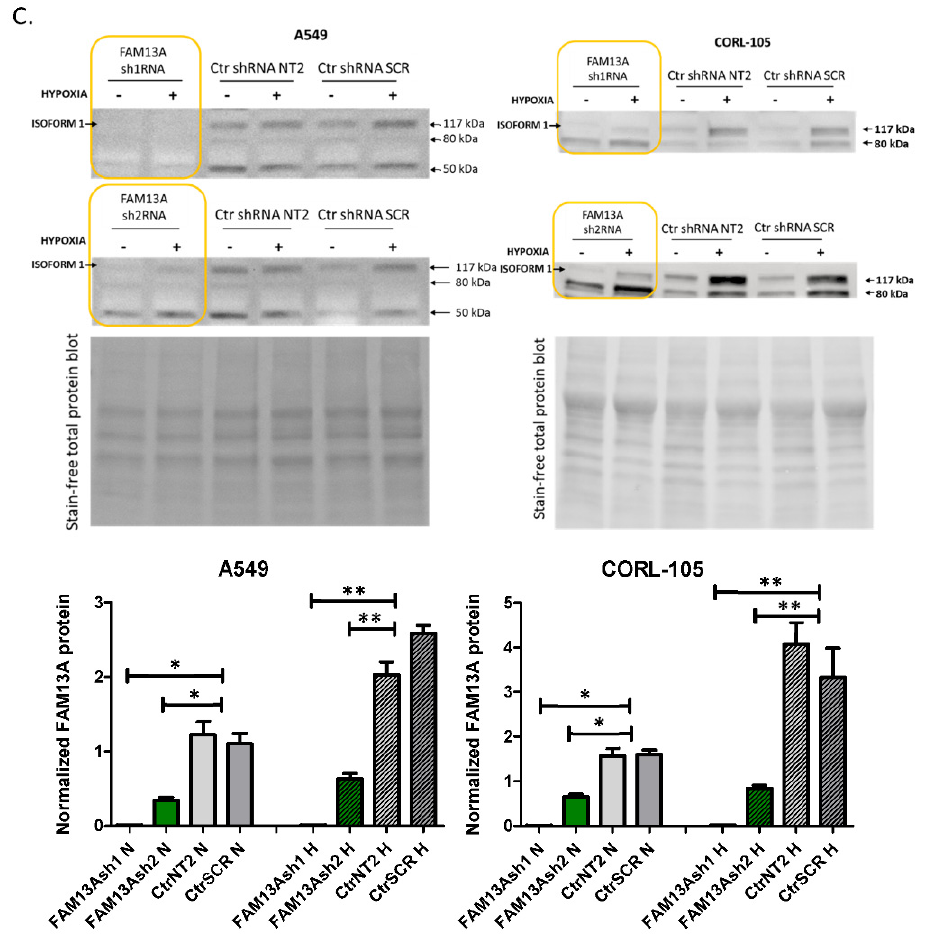
Figure 1. Generating lung cancer cell lines with FAM13A knockdown. FAM13A shRNAs (FAM13Ash1, FAM13Ash2) and control shRNAs (CtrNT2, CtrSCR) lentiviral particles were used to generate the stable transduction of A549 and CORL-105 cell lines. Transduction efficiency was assessed with the GFP marker. Knockdown of FAM13A mRNA and FAM13A protein was confirmed by real-time quantitative PCR and western-blot analysis. ( A ) Schematic indicating the binding site for the shRNA in the FAM13A mRNA. Two shRNA transcripts were designed using UCSC Broad Institute GPP Web Portal, against a coding sequence common to the most FAM13A isoforms with the RhoGAP functional domain. ( B ) RT-qPCR analysis of FAM13A expression in A549 and CORL-105 cell lines cultured under normoxia and hypoxia conditions for 72 h. Relative expression of FAM13A mRNA was determined as the mean normalized expression of FAM13A mRNA/GUS β mRNA. The experiments were performed in triplicate and repeated three times. The data are presented as the mean ± SD (* p < 0.05, ** p < 0.01, unpaired one-tailed t -test). ( C ) Western blot (WB) analysis of FAM13A expression in A549 and CORL-105 cell lines cultured under normoxia and hypoxia for 72 h. Relative FAM13A protein (117 kDA) amount was significantly decreased in FAM13A sh1/sh2RNA cells. Strong FAM13A expression was induced in controls (CtrNT2, CtrSCR) A549 or CORL105 cells after 72 h of hypoxia (+) compared to normoxia (-). Cropped images are displayed, full-length blots are presented in Supplementary Materials Figure S4. Total protein was used for normalization. Representative stain-free total protein blots are presented. The normalized protein factors are given at bar charts (N-normoxia, H-hypoxia, bars with texture). The data are presented as the mean ± SD (* p < 0.05, ** p < 0.01, unpaired one-tailed t -test). To analyze the effects of FAM13A silencing on the cell cycle, BrdU assay followed by 7AAD staining was used to distinguish the percentage of the cellular population that is in each phase of the cell cycle (G1, S, and G2). A549 FAM13A depleted cell